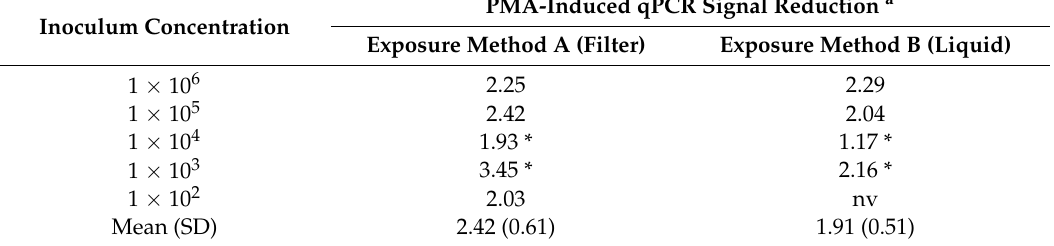
Table 2. PMA-induced quantitative polymerase chain reaction (qPCR) reduction of heat-killed L. pneumophila cells at different inoculum concentrations with Exposure Protocols A and